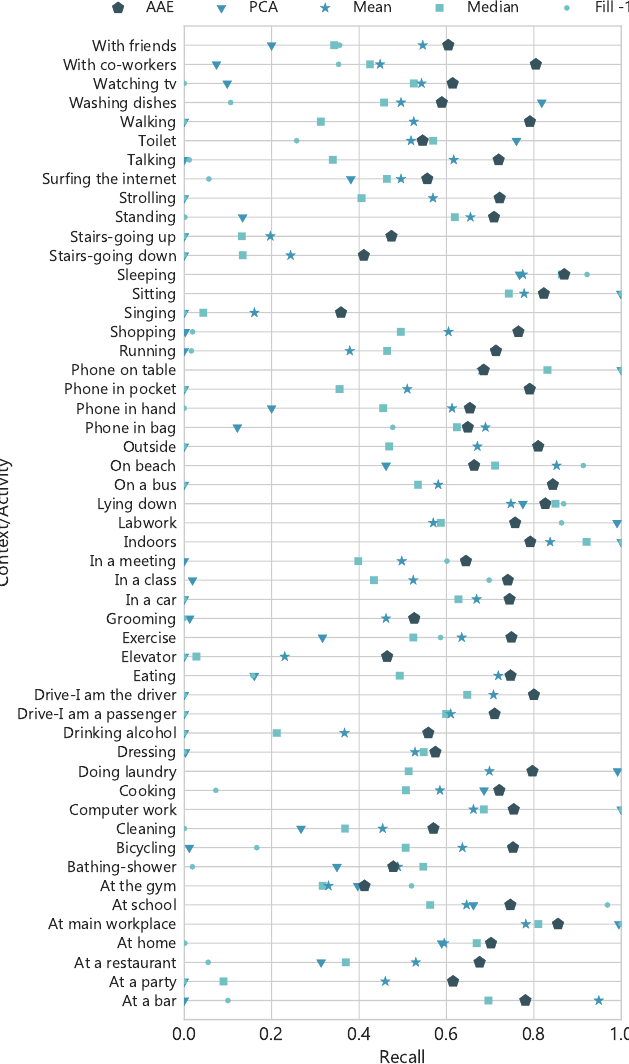
Figure 11. Recall of 51 contextual labels with 5-folds cross-validation. All the features from Acc , Gyro and Aud modalities are dropped to emulate missing features and imputed with different techniques to train a